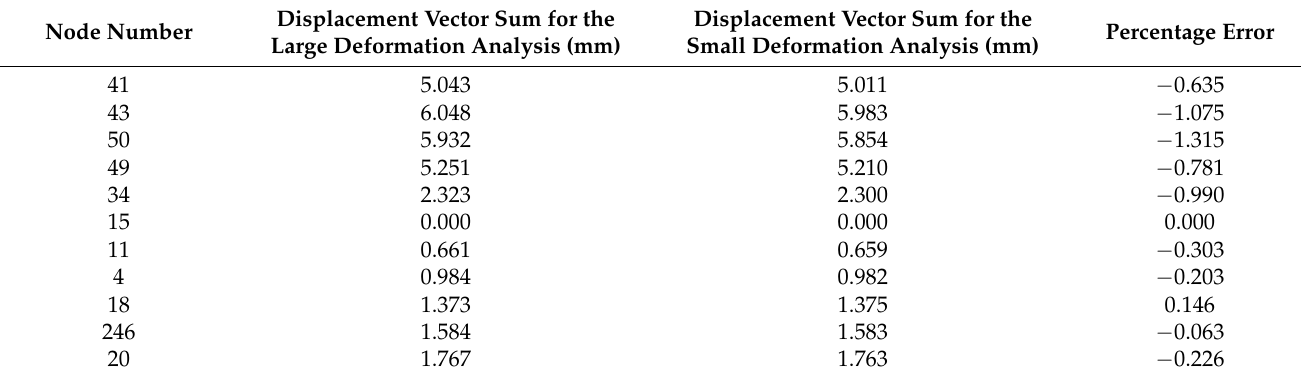
Table 2. Percentage Errors for Problem 2.